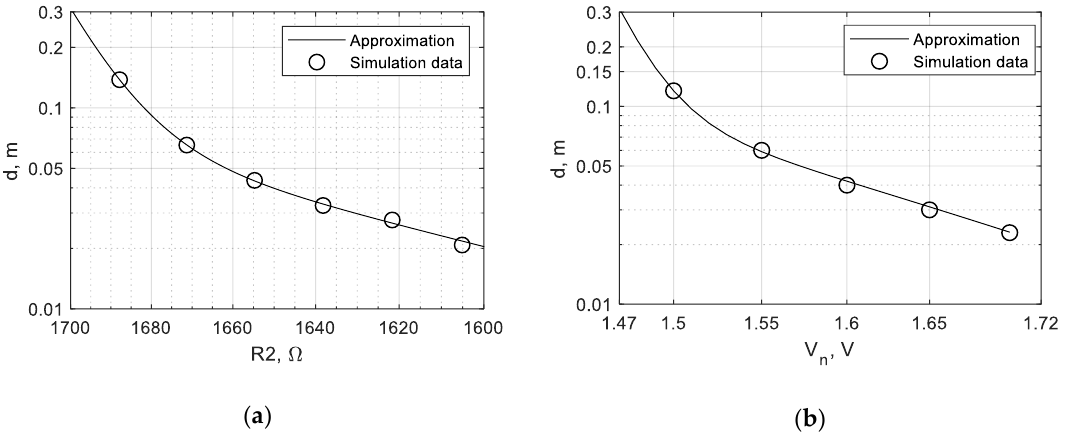
Figure 19. Detection range curves, data points, and approximation: ( a ) dependence from R2; ( b ) dependence from V n .